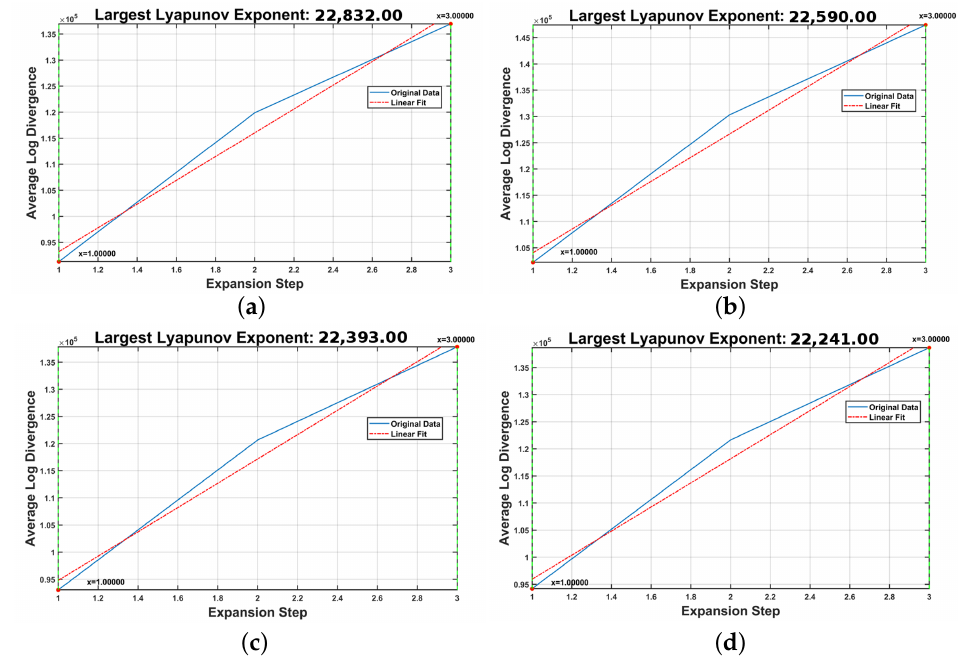
Figure 10. LLE for several signals from the RC dataset. ( a ) LLE for class P1, ( b ) LLE for class P6,